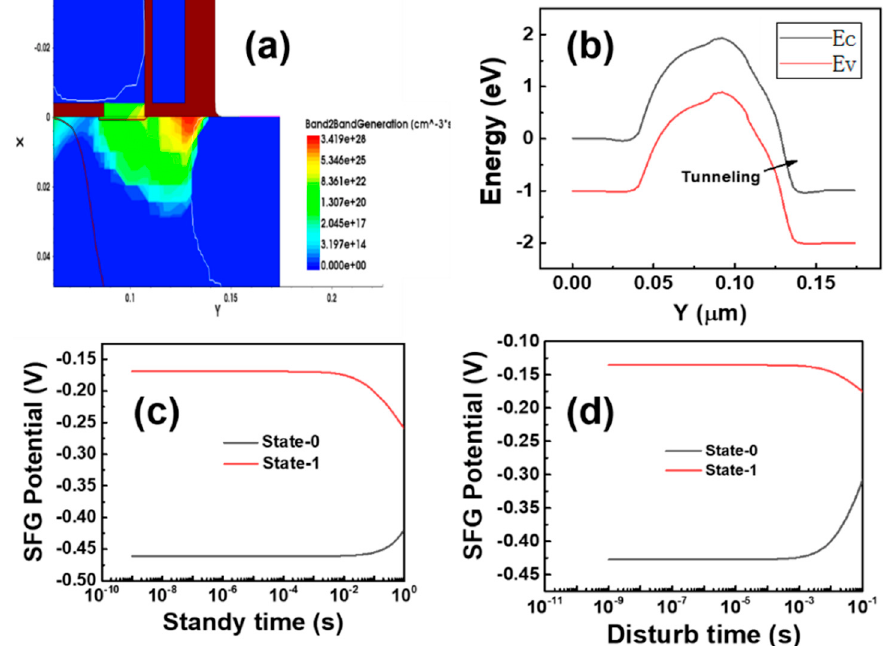
Figure 4. ( a ) The BTBT rate profile of the SFG transistor. ( b ) Band diagram when writing "1". ( c ) The SFG potential in state-1 and state-0 during the standby time for 1 s. ( d ) The SFG potential in state-0 and state-1 which varies with different disturbance times.